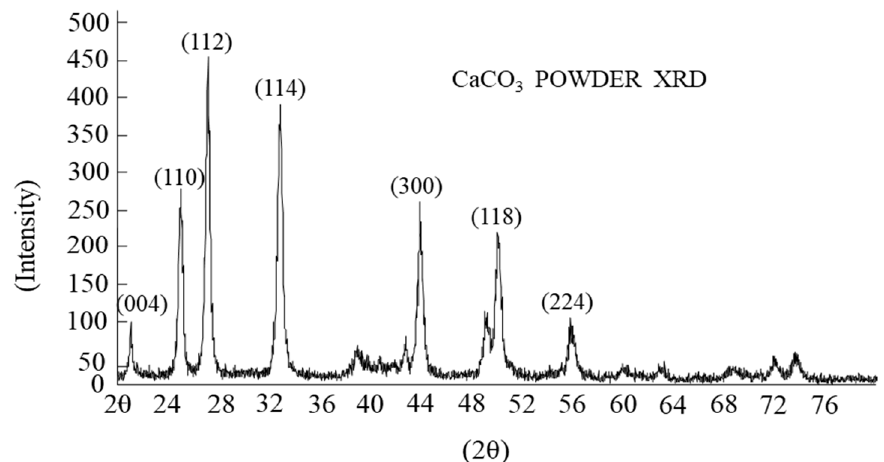
Figure 3. XRD spectra for No. 2 showing the intensity of vaterite.